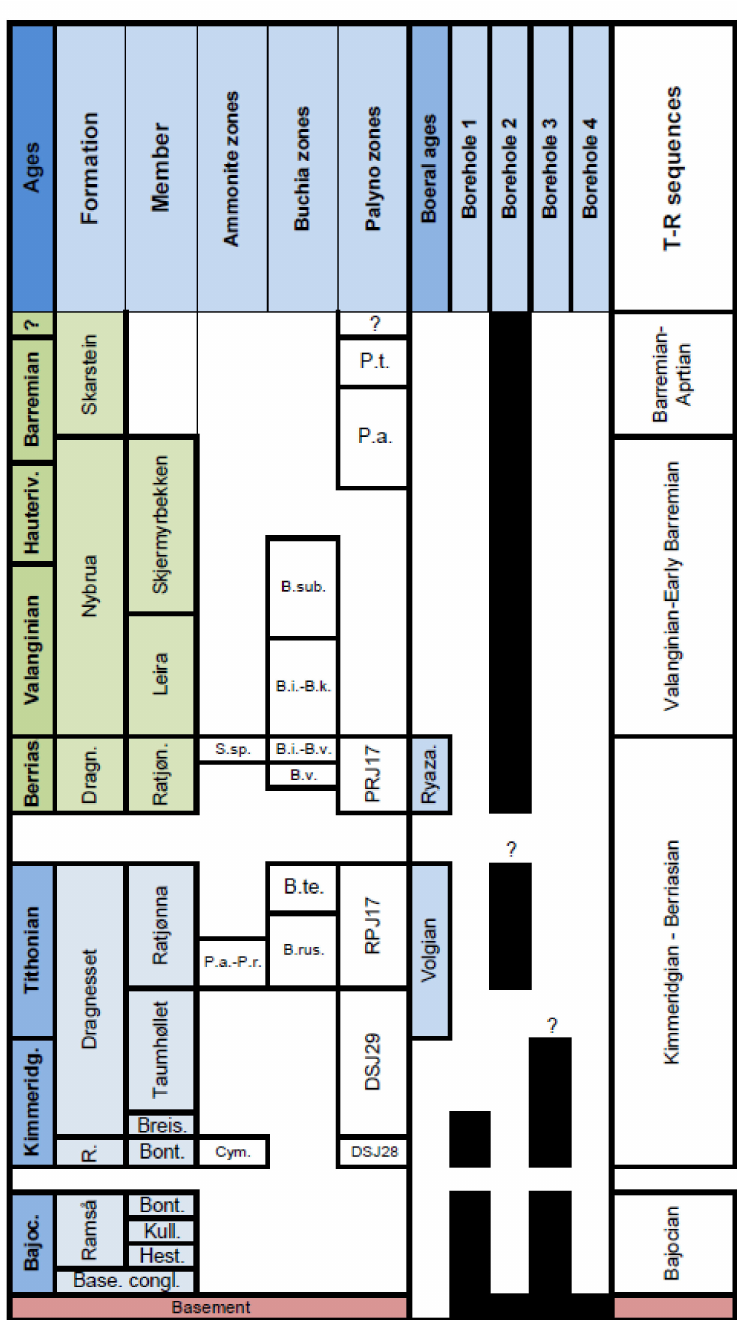
Figure 2. Lithostratigraphy and biostratigraphic zonations of the Jurassic–Cretaceous succession of the Ramså Basin, and the stratigraphic intervals covered by boreholes Bh 1, Bh 2, Bh 3 and Bh 4. Ammonite zones: S. sp. = Surites sp.; P.a.-P.r. = Progalbanites albani-Pavlovia rotunda; Cym. = Rasenia cymadoce. Buchia zones: B. sub. = Buchia sublaevis; B.i.-B.k. = Buchia inflata- Buchia keyserlingi; B.i.-B.v. = Buchia inflata-Buchia volgensis; B.v. = Buchia volgensis; B.te. = Buchia terebratuloides; B.rus. = Buchia russiensis. DSJ28 and DSJ29 = Dinocyst zones of Subboreal Northwest Europa, RP17 = Russian Platform zone 17. Palyno zones: P.t. = Pseudoceration toveae; P.a. = Pseudoceratium